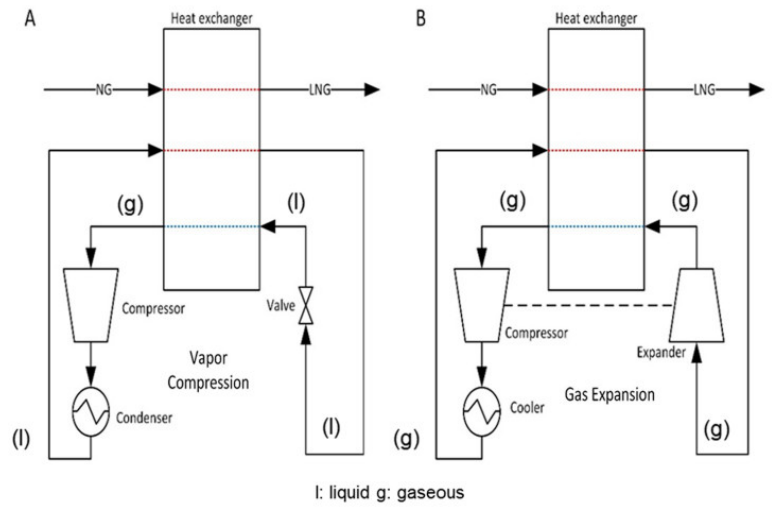
Figure 3. Schematic of vapor compression and gas expansion cycle: ( a ) Schematic of vapor compres- sion cycle; ( b ) Schematic of gas expansion cycle [16]. Reproduced with permission from Applied Thermal